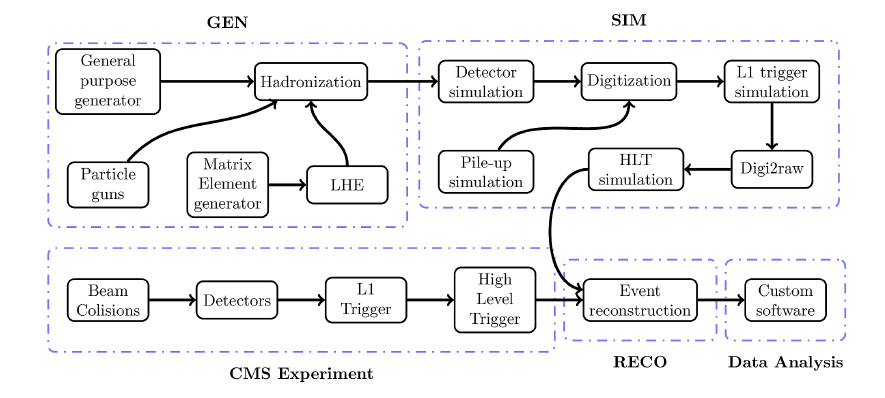
Figure 2. An overview of steps in production of CMS simulated